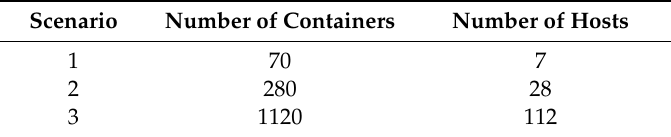
Table 2. Container and physical machine scale configuration